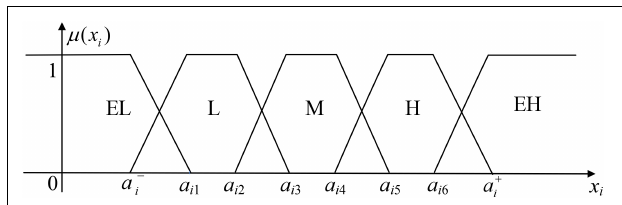
FIGURE 3 | Trapezoidal membership function.